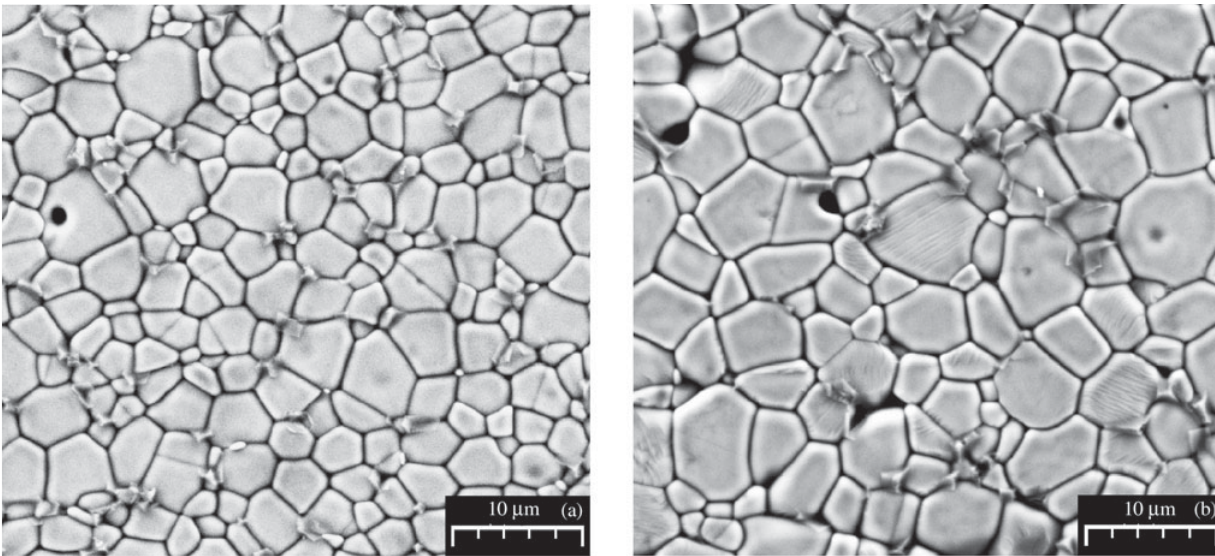
Figure 4. SEM micrographs of the SMNb0.2% composition sintered at 1300 °C for: (a) 1 h; (b) 4 h.